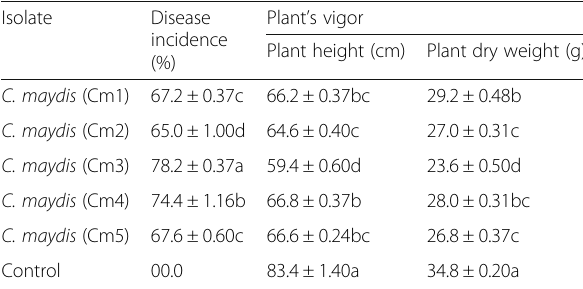
Table 2 Virulence of Cephalosporium maydis isolates on maize cv. Baladi under greenhouse conditions